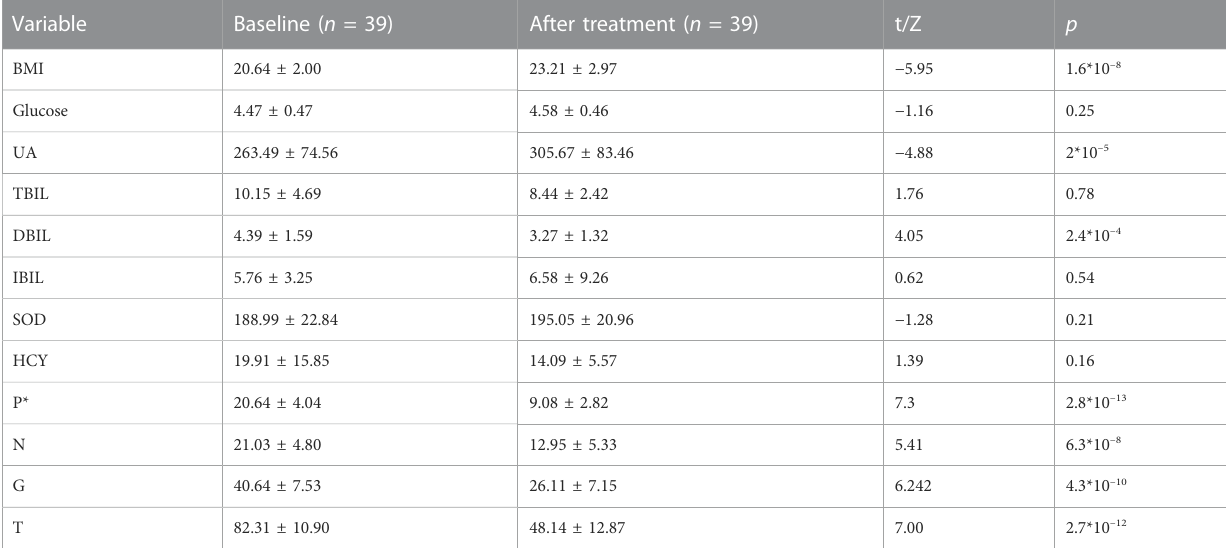
TABLE 2 Peripheral biochemical indicators at baseline and after treatment.